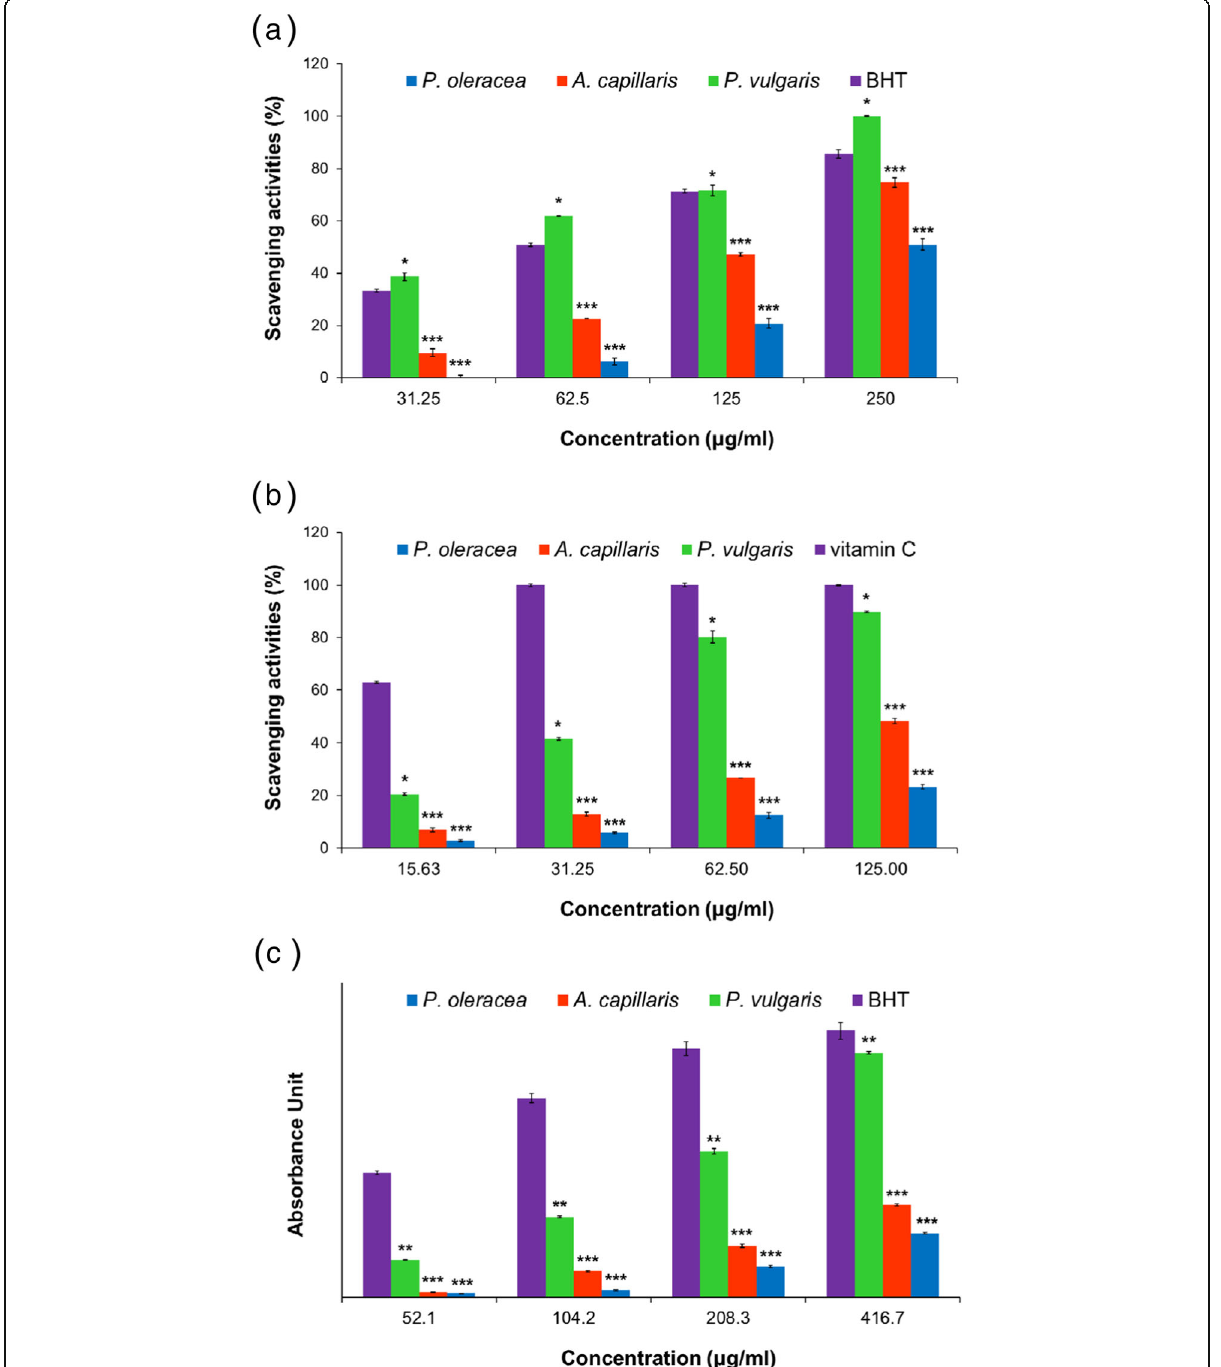
Fig. 1 DPPH and ABTS radical scavenging activities and reducing power of the aqueous extracts of A. capillaris , P. oleracea , and P. vulgaris . a DPPH radical scavenging activities. b ABTS radical scavenging activities. c Reducing power of the extracts. The data are presented as the mean±SEM. The asterisks indicate the significance of difference versus the standard (BHT or vitamin C): * p <0.05, ** p <0.01, *** p <0.001. The results are representative of three independent